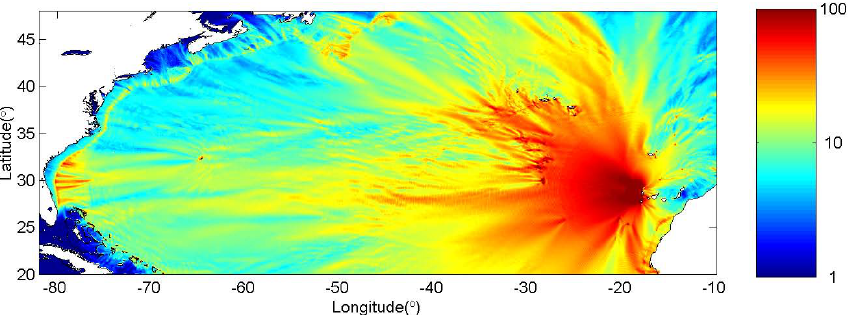
Fig. 21. Maximum water surface elevations (m) in the North Atlantic basin. Due to initial condition, more wave energy is projected westwards compared with the studies by Løvholt et al.